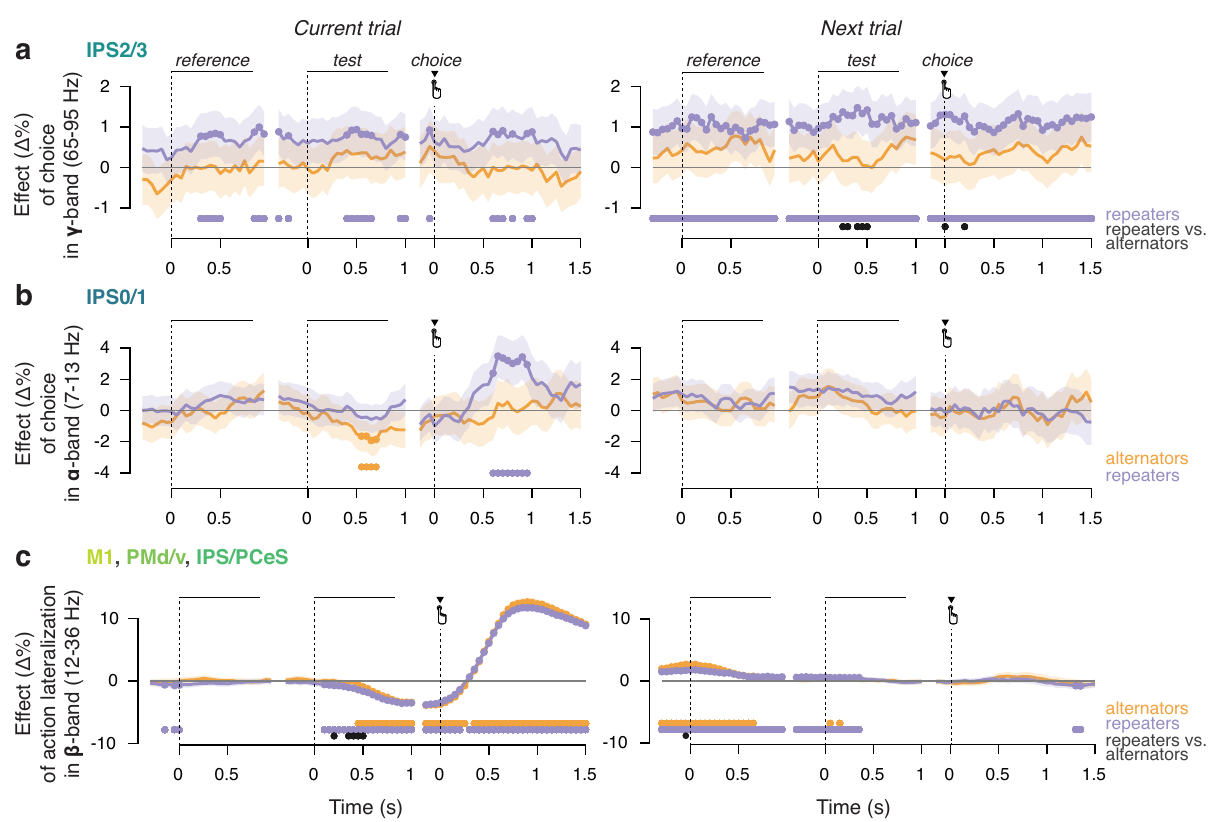
Fig. 5 | Time course of history effects in cortical signals. Time-resolved effect sizes from a general linear mixed model (see “ Methods ” ), separately for both subgroups. a Effectofcurrentand previouschoice onIPS2/3gamma-band activity. b Effect of current and previous choice on IPS0/1 alpha-band activity. c Effect of